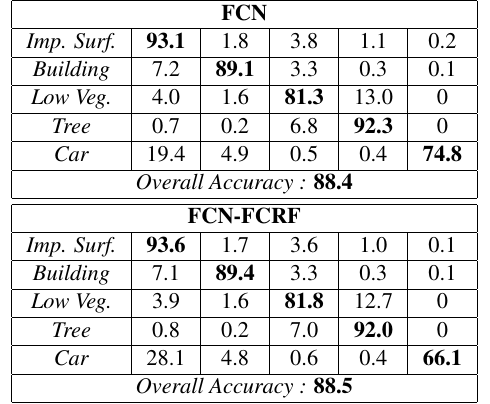
Table 2: Confusion matrices and overall accuracies for the test set of the ISPRS benchmark (all numbers in %). separate results per model are given. Recall that classifier scores